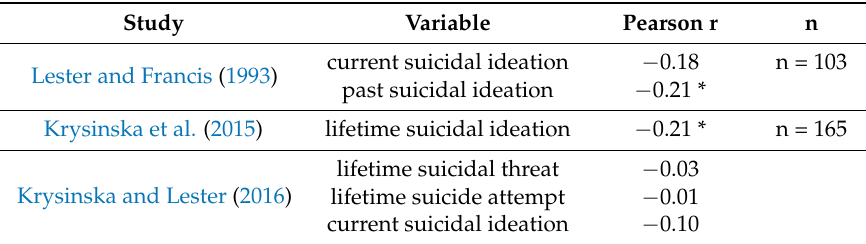
Table 1. Research using Francis’s Religiosity Scale (Pearson correlations shown). Study Variable Pearson r n current suicidal ideation − 0.18 n = 103 Lester and Francis (1993) past suicidal ideation − 0.21 * Krysinska et al. (2015) lifetime suicidal ideation − 0.21 * n =